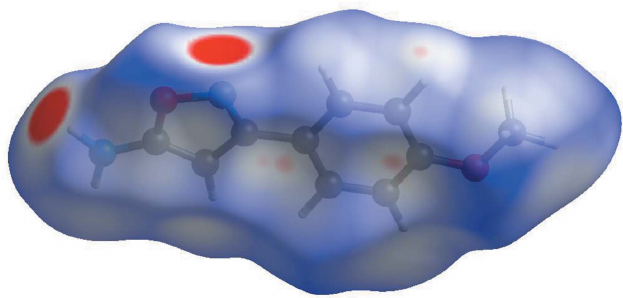
Figure 6 Hirshfeld surface for (II) mapped over d norm .